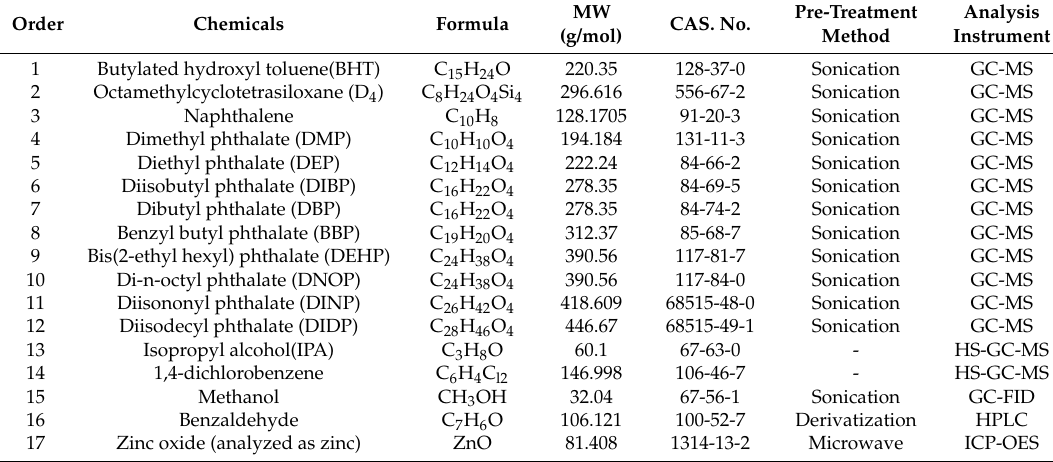
Table 2. Information on 17 target hazardous ingredients investigated in this